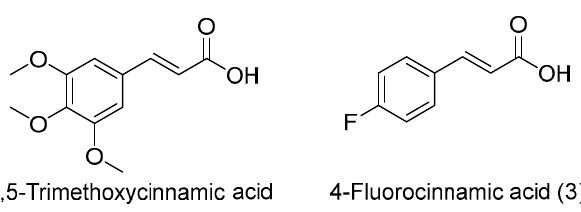
Figure 1. Chemical structure of 3,4,5-trimethoxycinnamic acid and compound 3 .